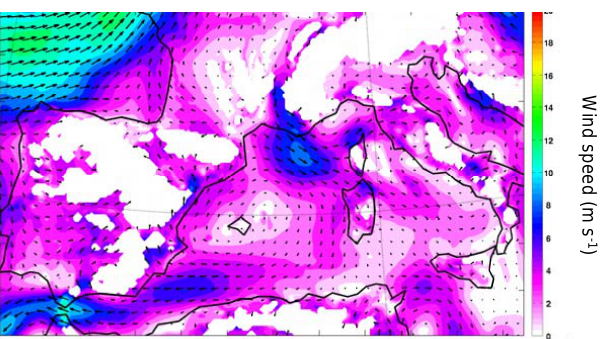
Figure 3. Example of wind maps at 925mbar for 26 June and 3 July 2012. The maps are obtained from the WRF-Chem model (Weather Research and Forecasting – Chemistry) at 10km horizon- tal